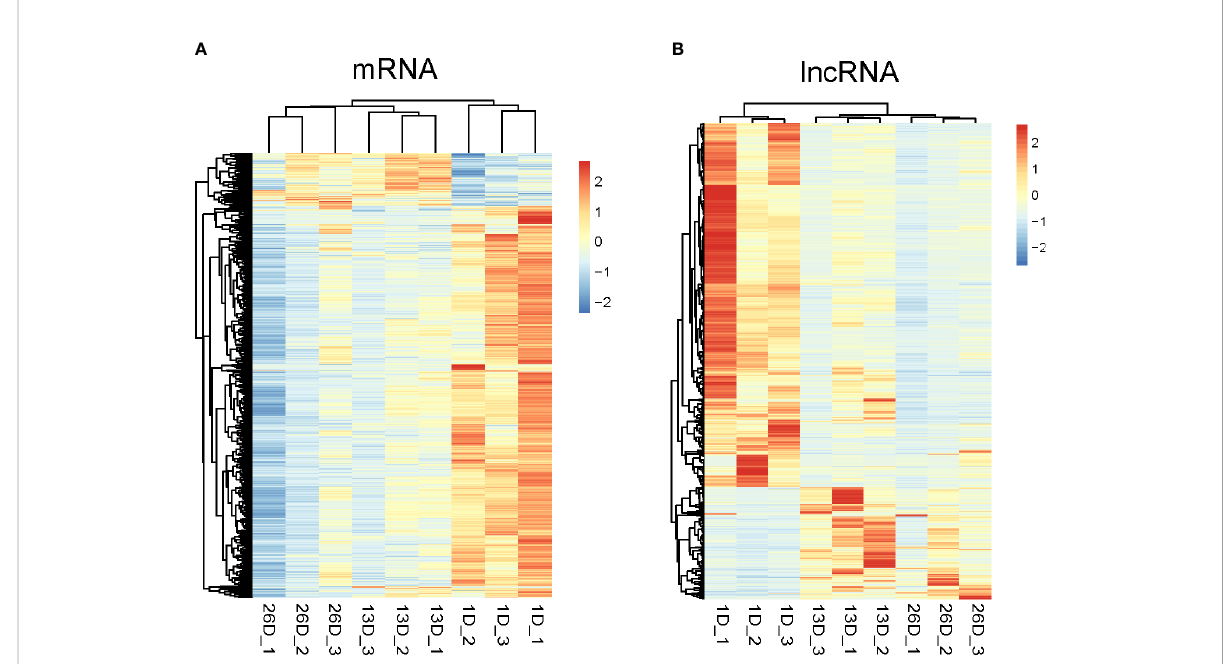
FIGURE 3 Hierarchical clustering analysis of differentially expressed mRNAs and lncRNAs in pigeon BFs. Heatmap representing the Z-score for normalized expression values of DE mRNAs (A) and lncRNAs (B) . The heatmap is drawn with Pretty Heatmap at